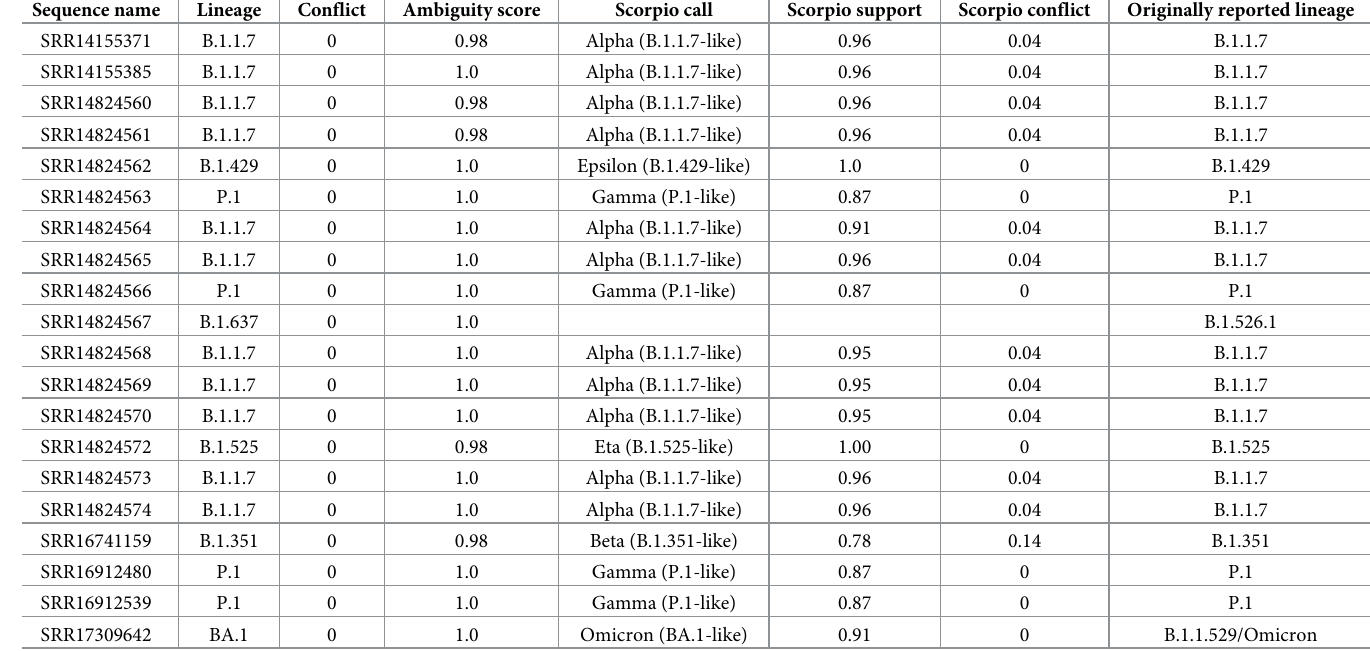
Table 3. Comparison of originally reported lineages and lineages identified by Pangolin after genotyping publicly available sequencing reads of SARS-CoV2 with our